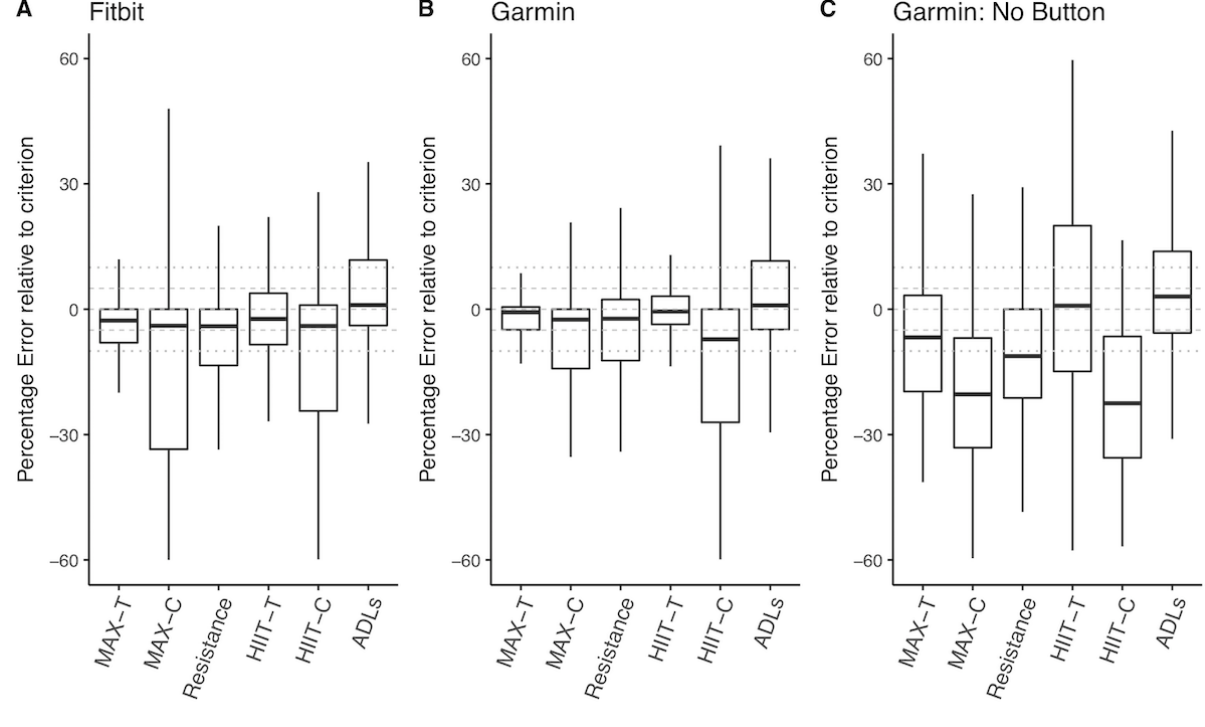
Figure 2. Percent relative error (RE) in heart rate (HR) across all the activities from all the devices tested. Percent error is calculated as (device measurement-reference standard) × 100/reference standard. The box-whisker plots indicate the error with the 25% quartile, median (50% quartile), and 75% quartile marked in each box plot. Gray horizontal dashed lines indicate the 5% error threshold, and the dotted lines indicate the 10% error threshold. ADLs: activities of daily living, HIIT-C: high-intensity interval training-Cycle ergometer, HIIT-T: high-intensity interval training-Treadmill, MAX-C: MAX-Cycle ergometer, MAX-T: